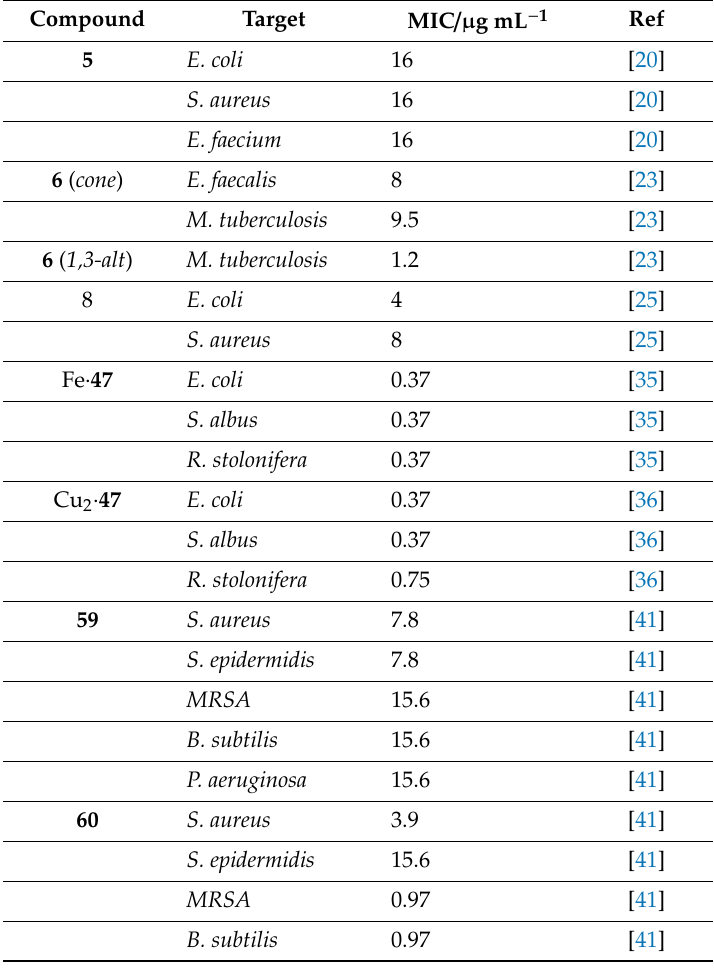
Table 1. Summaryofmacrocycleswithsignificantantibioticactivities.